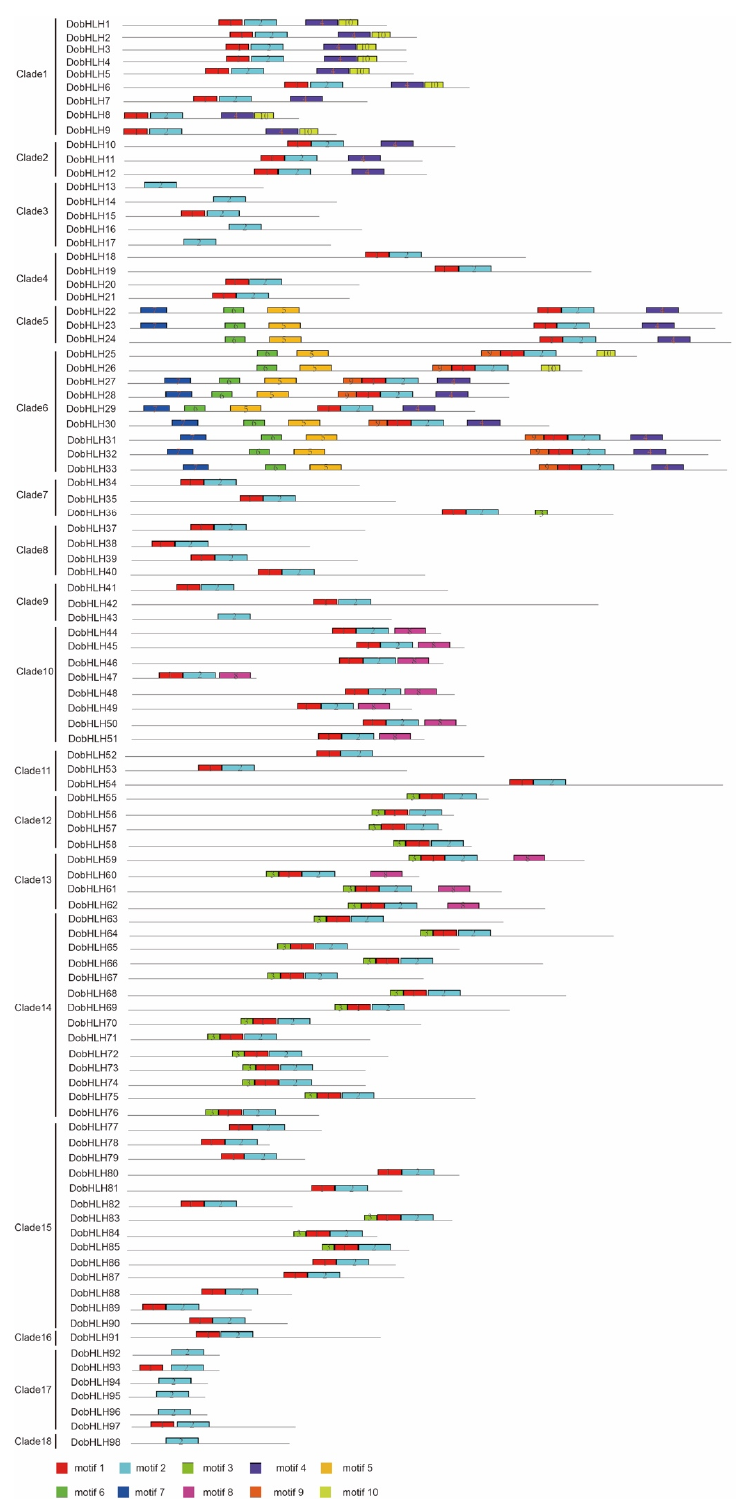
Figure 3. The conserved motifs of DobHLH proteins predicted by MEME. The colored boxes with numbers represent 10 conserved motif and the grey lines indicate non-conserved